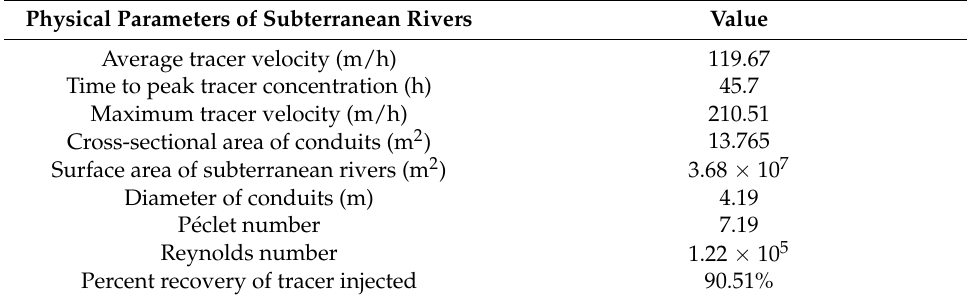
Table 3. Tracer test results of subterranean rivers calculated using QTRACER2.